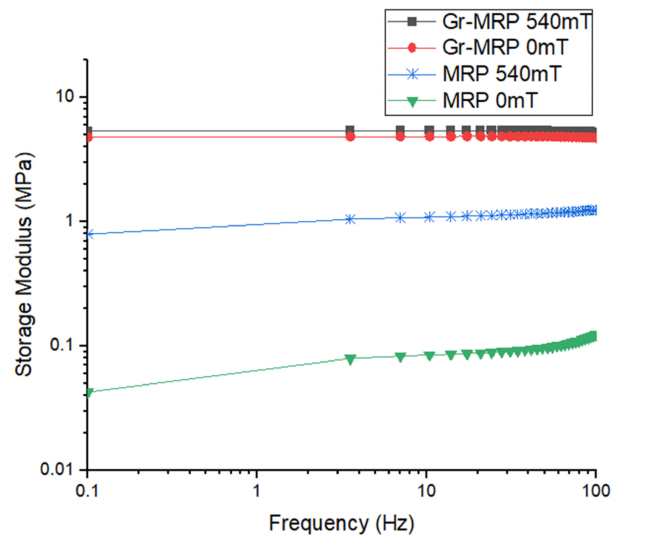
Figure 10. The frequency-dependent storage modulus of MRP and Gr–MRP for different magnetic fields of 0 and 540